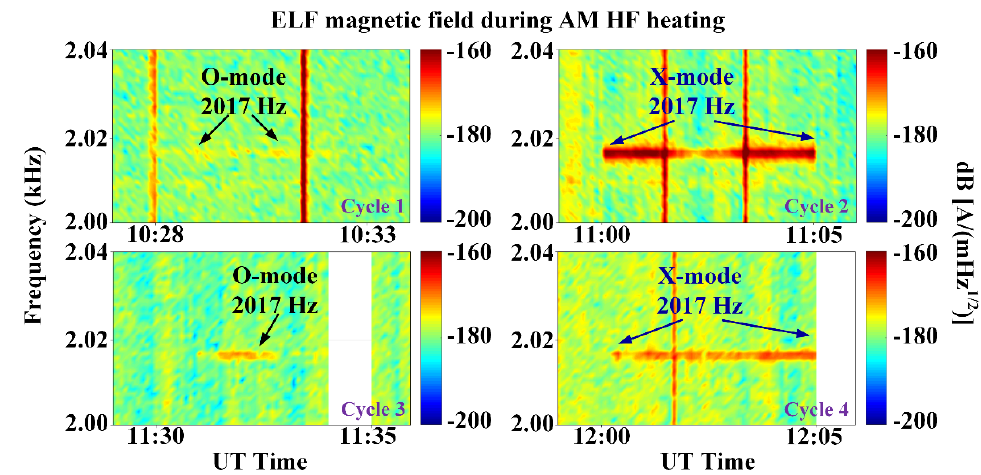
Figure 4. Spectrogram of the ELF magnetic field received by the ground receiver in AM HF heating.